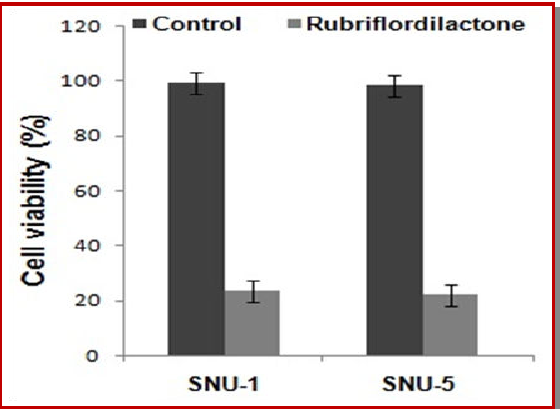
Figure 3: Rubriflordilactone A treatment reduced the viability of cancer cell in acidic media after 24 hours